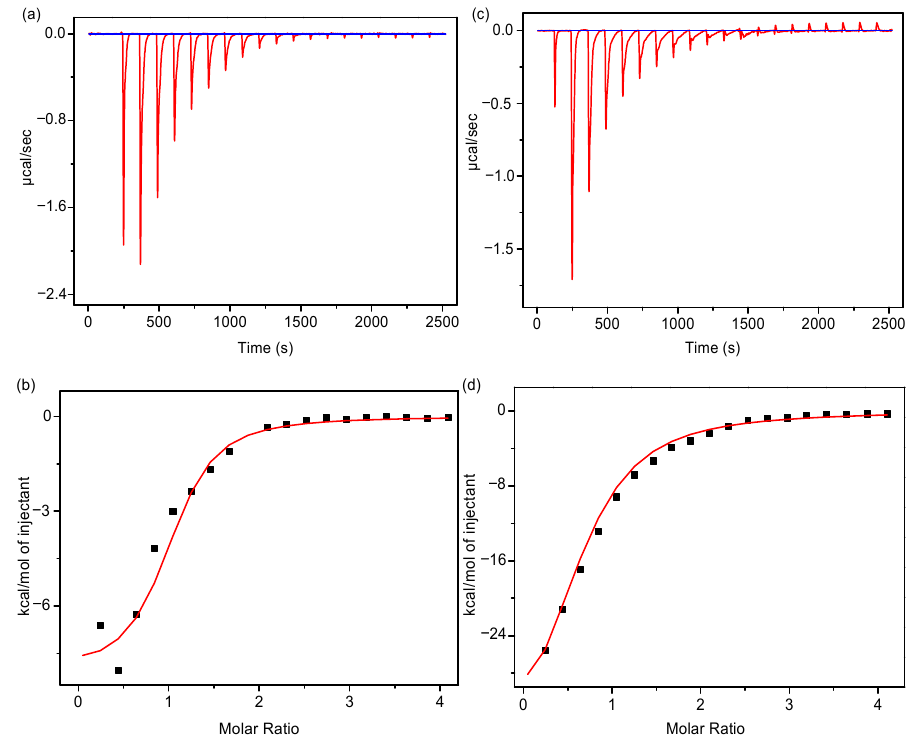
Figure 2. ( a , b ) Nap1 (1.0 mM) and ( c , d ) NapA (1.0 mM) titration of the Q[8] (0.1 mM) isothermal titration heat curve and nonlinear fitting result of molar ratios at 25 °C.